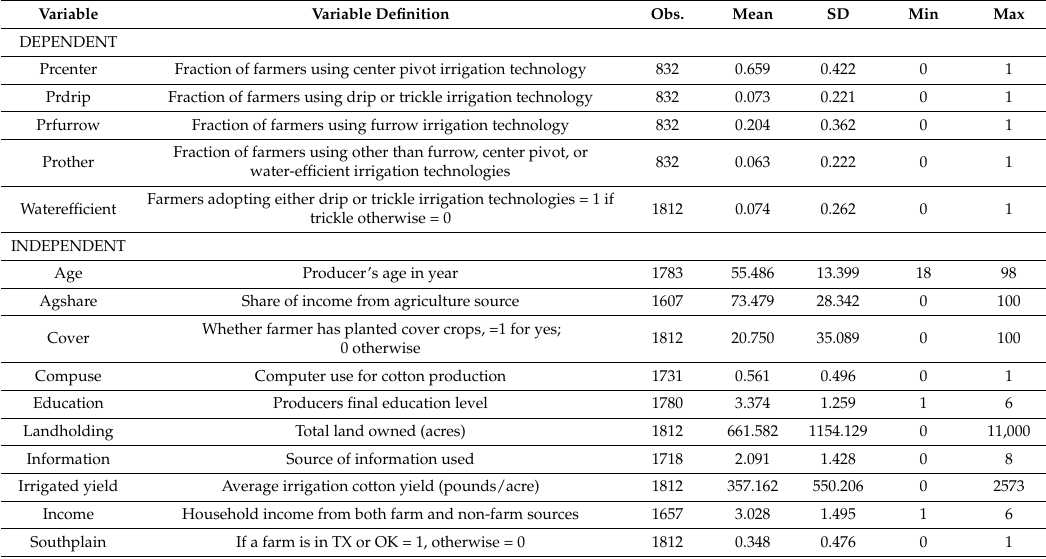
Table 2. Definition and summary of